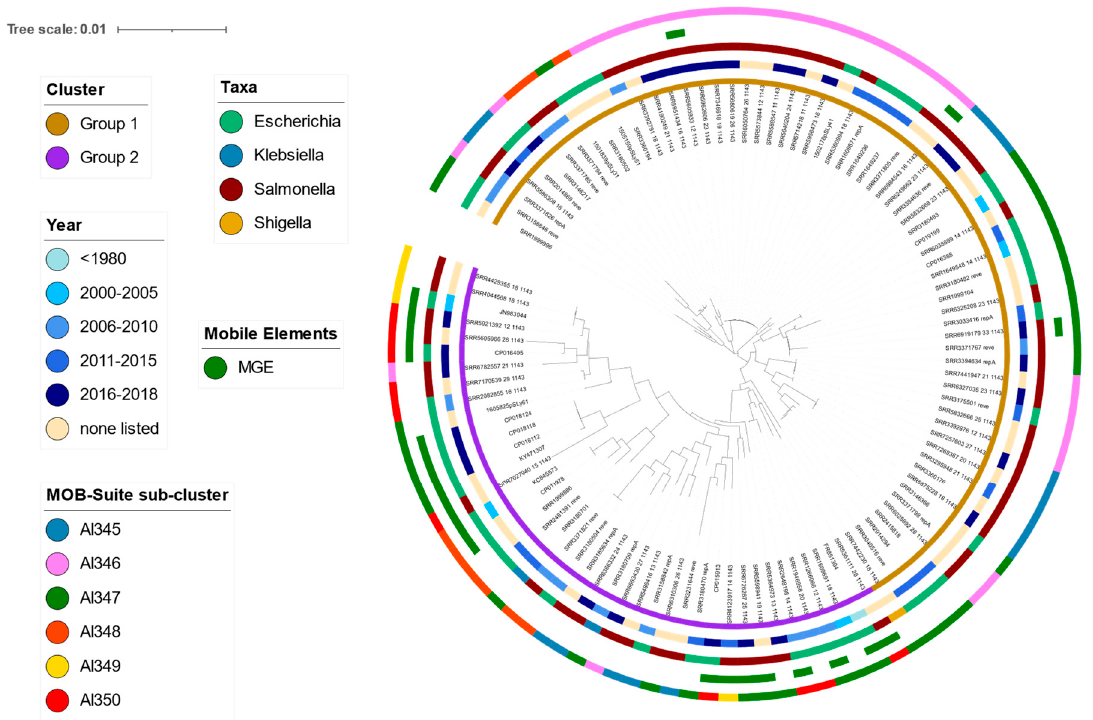
Figure 3. Phylogenetic analysis of the core gene SNP analysis for the USA subset of IncI2 plasmids. Rings (starting from inner to outer) correspond with: (1) designation of Group 1 or 2 based on core gene phylogeny, (2) year of isolation, (3) taxa, (4) presence or absence of mobile genetic elements and, (5) sub-cluster assigned using MOB-suite. All colors are indicated in the legends. Figure created